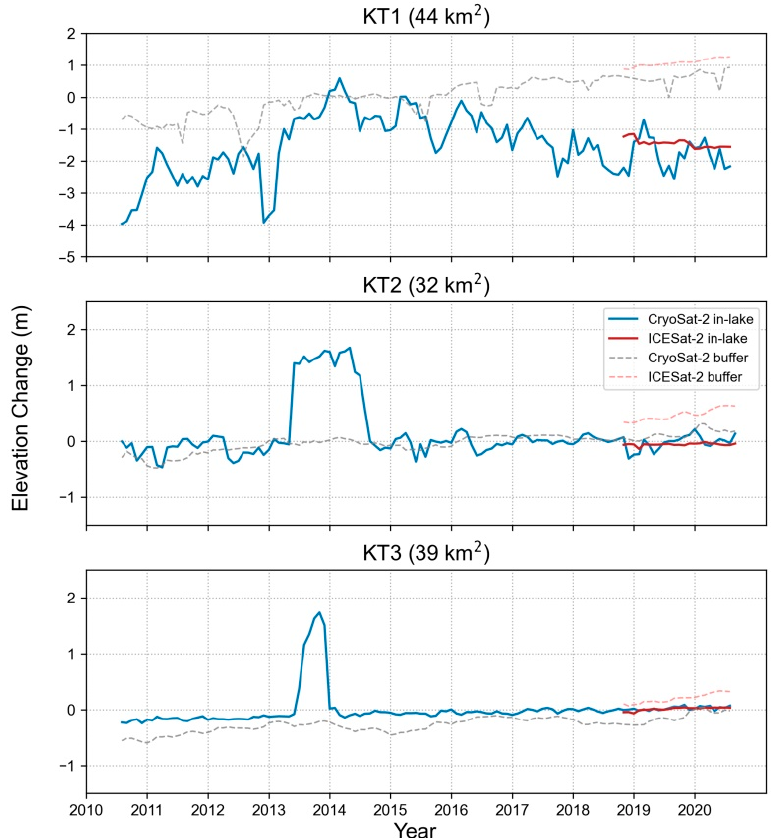
Figure 4. Time series of the ice surface elevation changes of the subglacial lakes beneath the Kamb Ice Stream. The subplots are arranged from upstream to downstream.